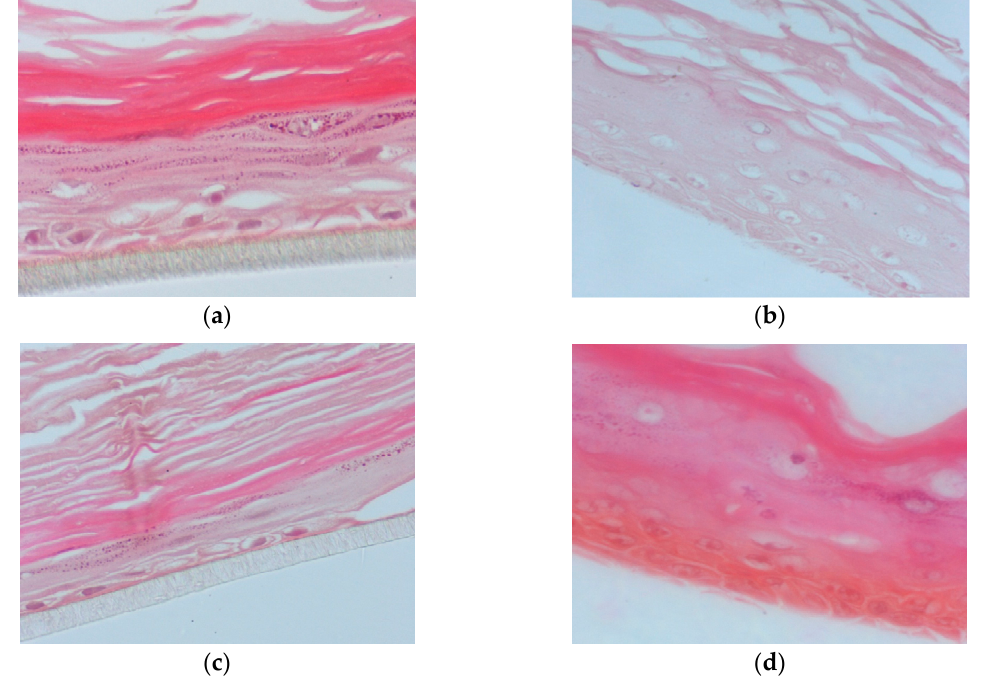
Figure 6. Evaluation of the protective effect of propolis extracts against UVB-induced skin damage. Epiderm TM EPI-200 reconstituted human skin tissues were treated on their apical surface with 20 μ g/mL of either PR_1b or PR_9b for 2 h, washed with PBS, and then exposed to 55 mJ/cm 2 of UVB irradiation. After exposure, the apical surface of the tissues was incubated in the presence or absence of each of the propolis extracts for 2 h, then washed with PBS and placed in culture medium. After 24 h, the tissues were harvested and sections were taken. Representative figures (at 400× magnification) of eosin and hematoxylin staining of untreated tissues ( a ), UVB-irradiated skin tissues ( b ) and tissues treated with UVB and either PR_1b ( c ) or PR_9b ( d ).